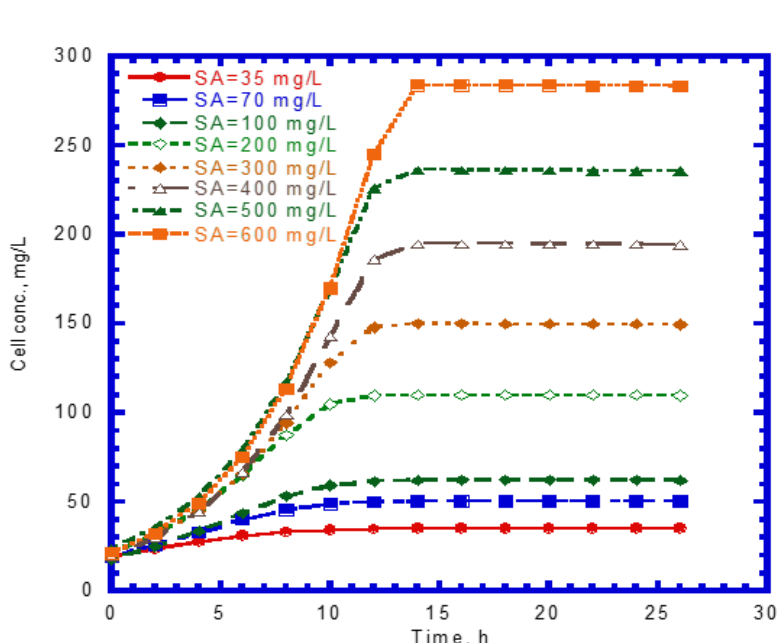
Figure 2. Single sodium salicylate (SA) biodegradation by P. putida at various initial phenol concen- trations: ( a ) SA biodegradation and ( b ) cell growth.